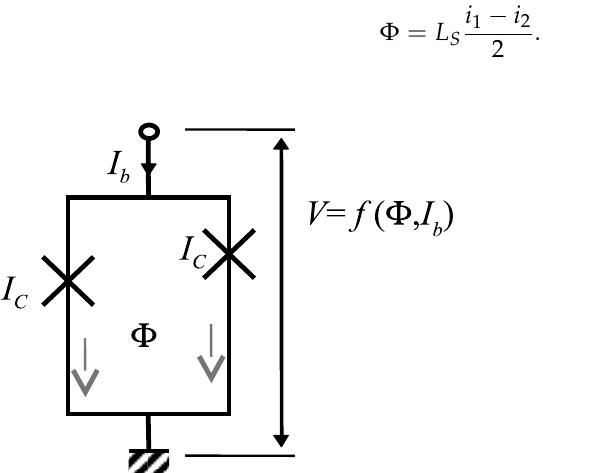
Figure 1. Basic SQUID with perfect symmetry, with crosses representing JJs. The magnetic flux originating from the bias current has zero net